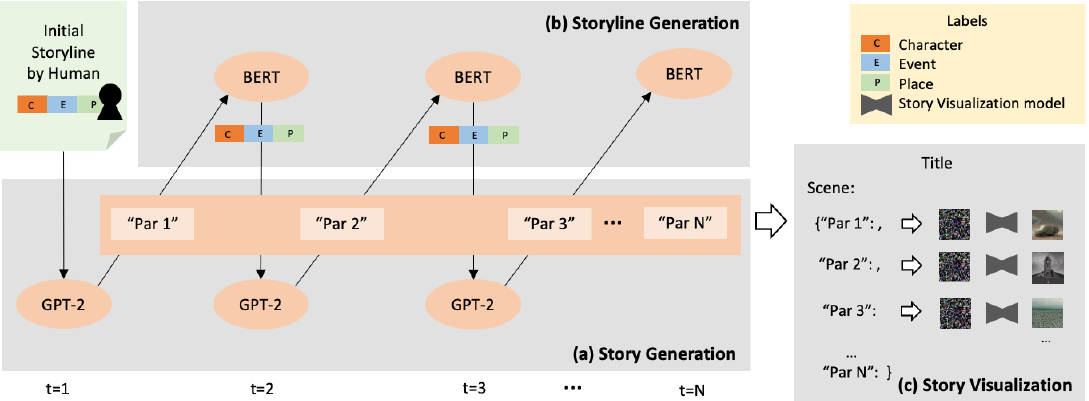
Figure 3. Our proposed multi-modal story generation framework. The framework consists of three parts: ( a ) Our GPT-2-based story generation model creates the current story paragraph (par). A series of these paragraphs becomes an entire scene. ( b ) Our BERT-based storyline guidance model generates the storyline, which is composed by character, event, and place. ( c ) Our diffusion-based story visualization model generates a representative image. A single paragraph is fed on the diffusion model, and the final output is each following